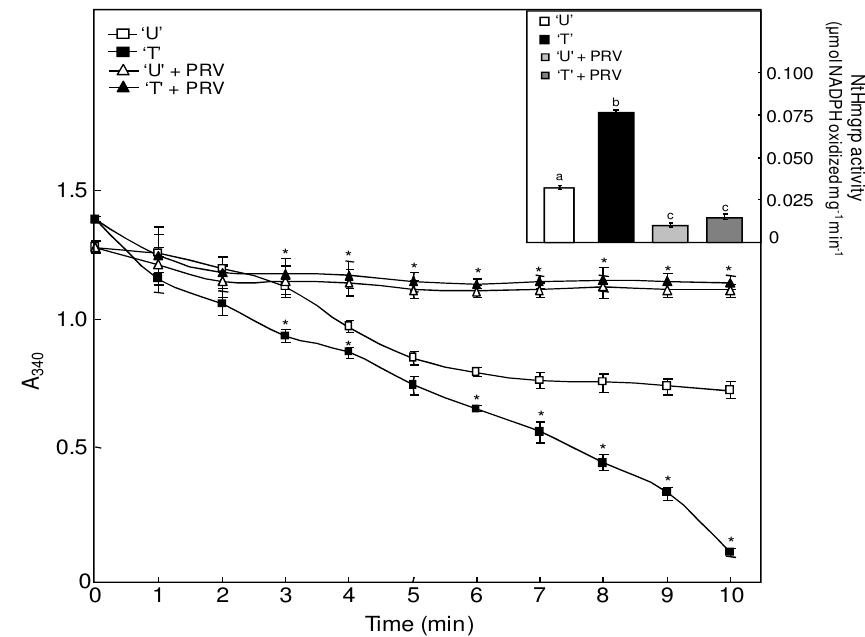
Figure 3. NtHMGR activity measurement Differential NtHMGR activity from ‘U’ and ‘T’ cellular-extract (~50 µg) in the absence or presence of reference statin drug, PRV (~30 μM) was measured. NADPH consumption rate was monitored at 37 ºC at 340 nm by spectrophotometric-scanning for 10 min. The specific activity of ‘U’ and ‘T’ calculated between 60-600 s was observed to be 0.03 and 0.08 μmol NADPH oxidized mg -1 (protein) min -1 , respectively. The inset depicts HMGR specific activity of each sample at the end of test period (10 min). Means ± SDs, n = 3, wherein * indicate the significant differences ( p ≤ 0.05 ). PRV - Pravastatin, ‘U’- Untreated and ‘T’ - GA 3 treated